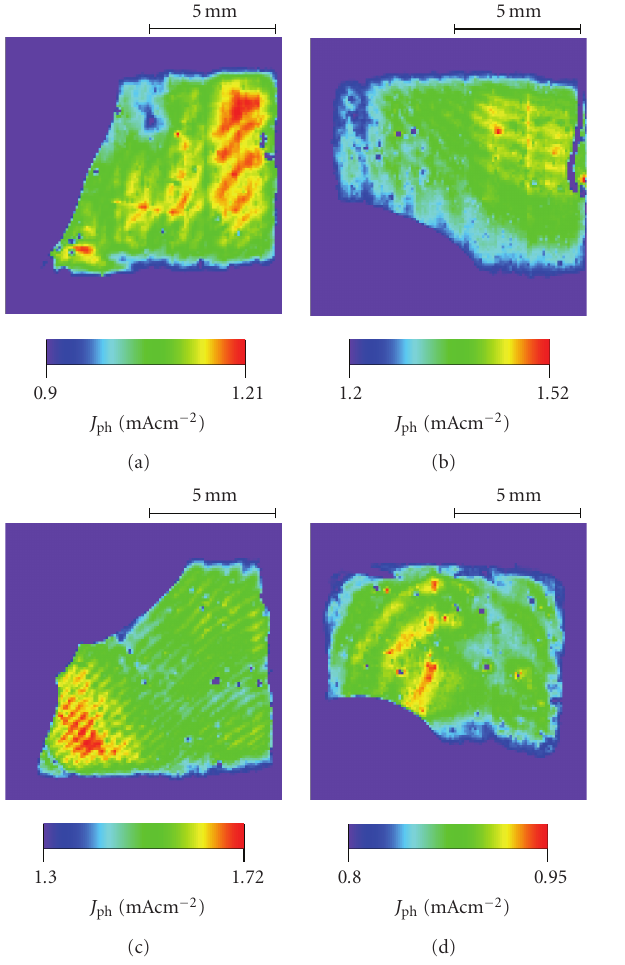
Figure 6: Photodegradation is not detected in photocurrent images of nanocrystalline TiO 2 solar cells with bleached electrolyte, which causes significantly decreased photocurrent densities during illumination. All cells are sensitized with N3 dye and were illuminated with simulated solar light in round central areas only. The illumination period was 150 days (3600 hours). The cells were at the end not completely wetted with electrolyte.